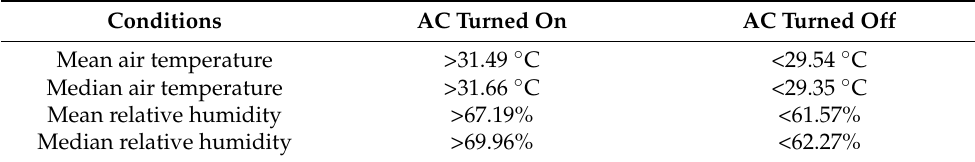
Figure 3. Relation between air temperature and relative humidity and AC on and off status ( left ); relation between periodic average of air temperature and relative humidity and AC set point temperature ( right ). Table 3. Instantaneous conditions that result in turning the air conditioner on and off.